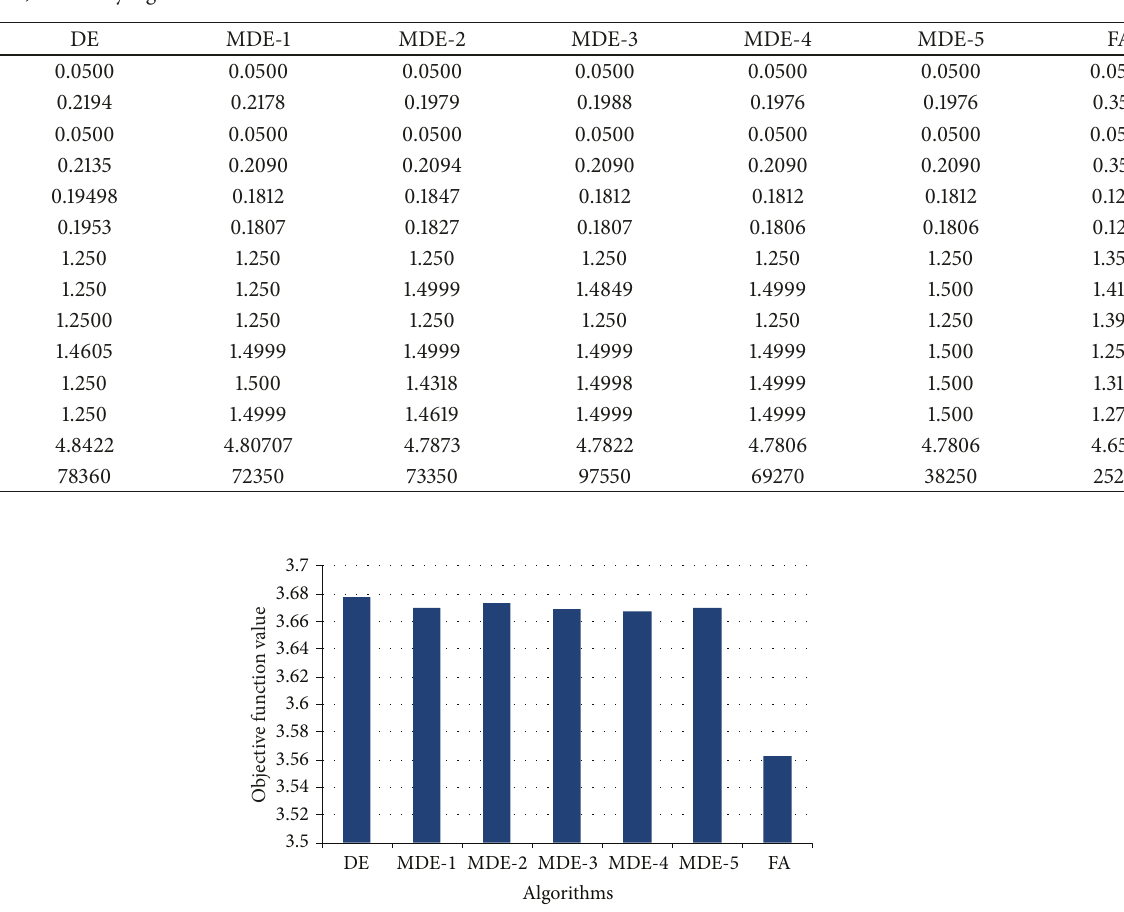
Table 1: Best design variables, objective function values (F), and total number of function evaluations (NFE) for IEEE 3-bus model by DE, modified DE, and firefly algorithms.